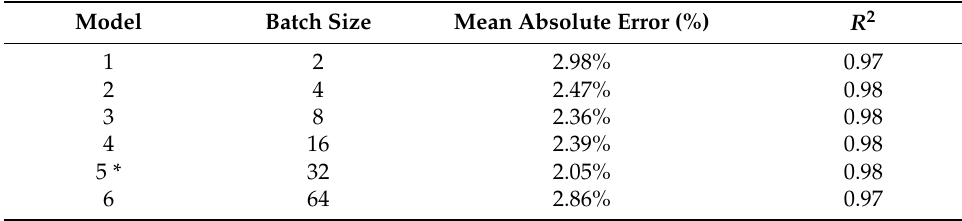
Table 6. Hyperparameter tuning for batch